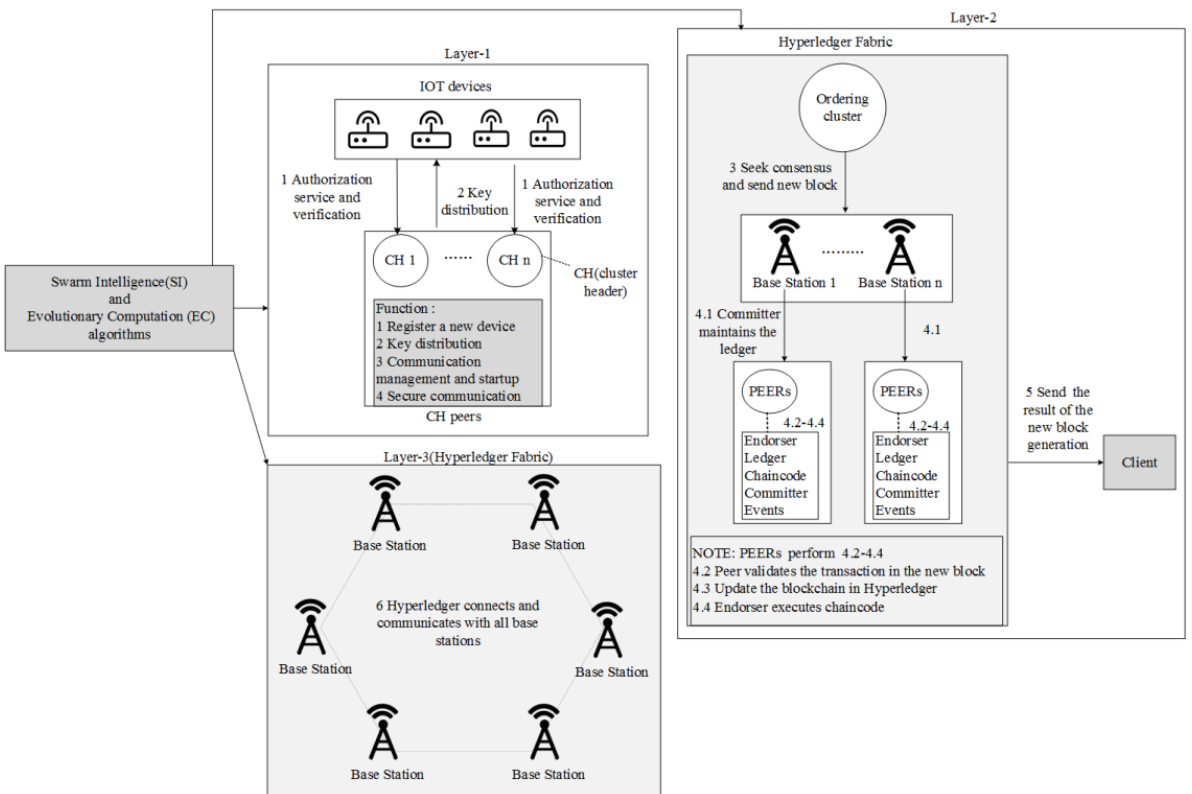
Figure 16. Reconstruction diagram of reference [39].